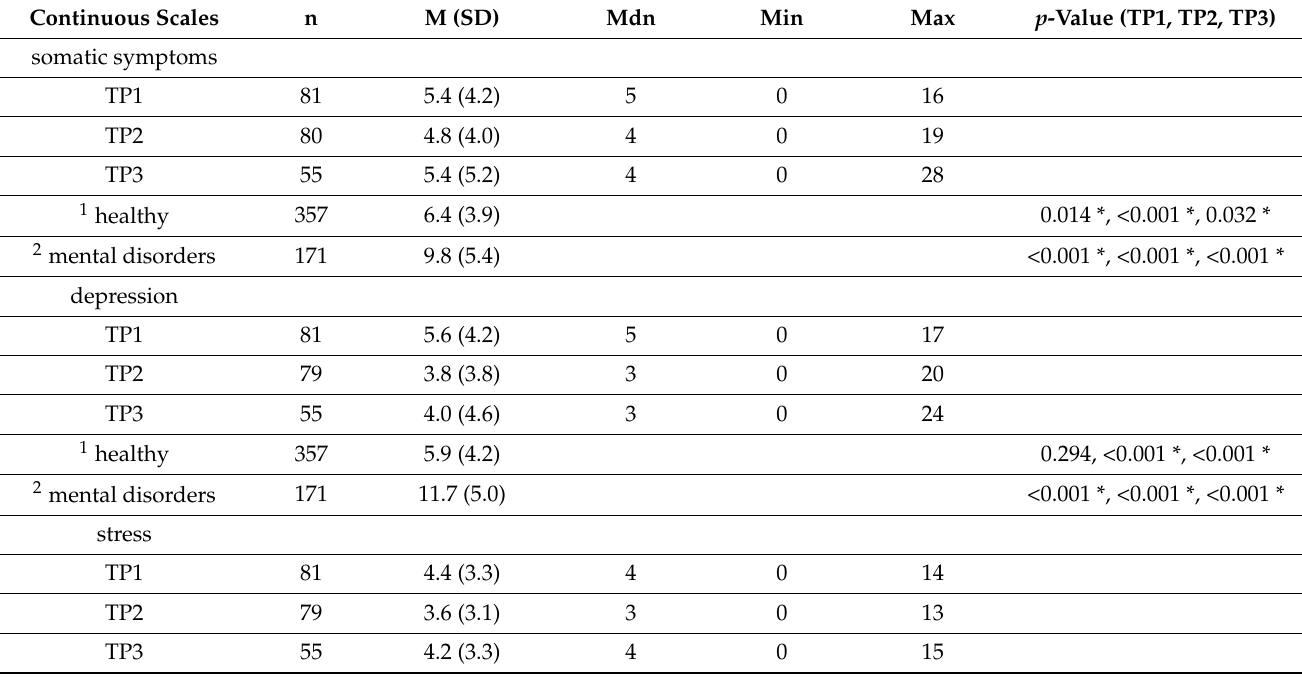
Table 5. Descriptive evaluation and Wilcoxon signed-rank test of the continuous scales (PHQ-D) compared to the values from two reference